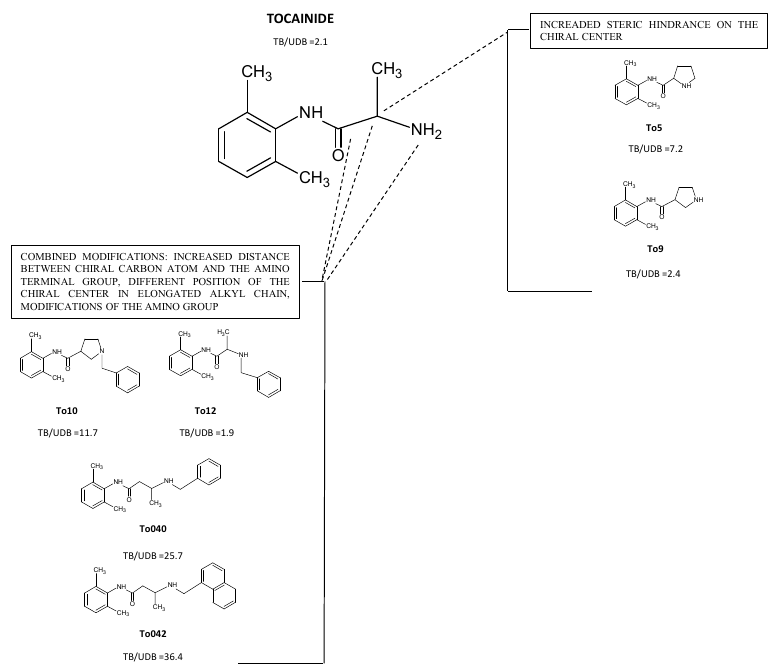
Figure 3. Chemical structure of Tocainide and its newly synthesized analogs. The boxes show the most interesting compounds with the ratio between IC 50 values during tonic block (TB) and use-dependent block at the frequency of 10 hertz (UDB) (IC 50 TB/IC 50 UDB 10-Hz). The ratio is shown to allow an easier comparison of the use-dependent behavior of each compound